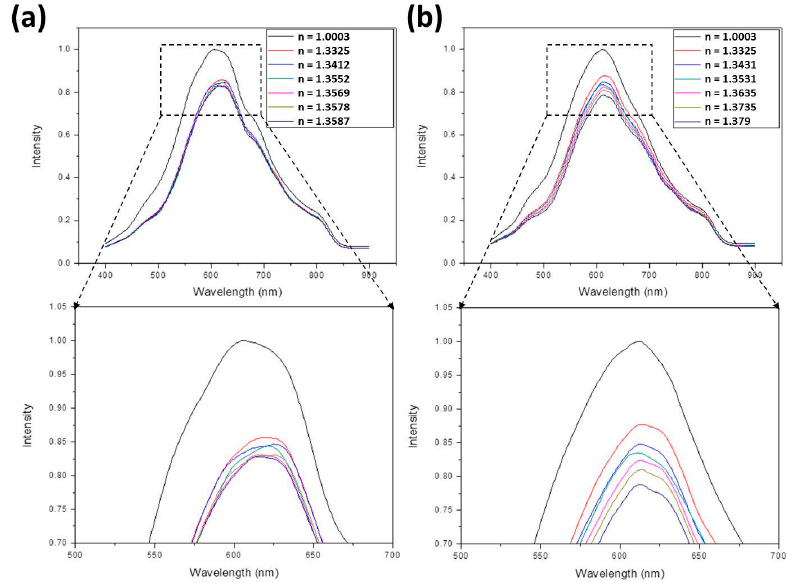
Figure 6. The normalized SPR spectra of ( a ) ethanol-methanol and ( b ) glucose solutions with different refractive indices.